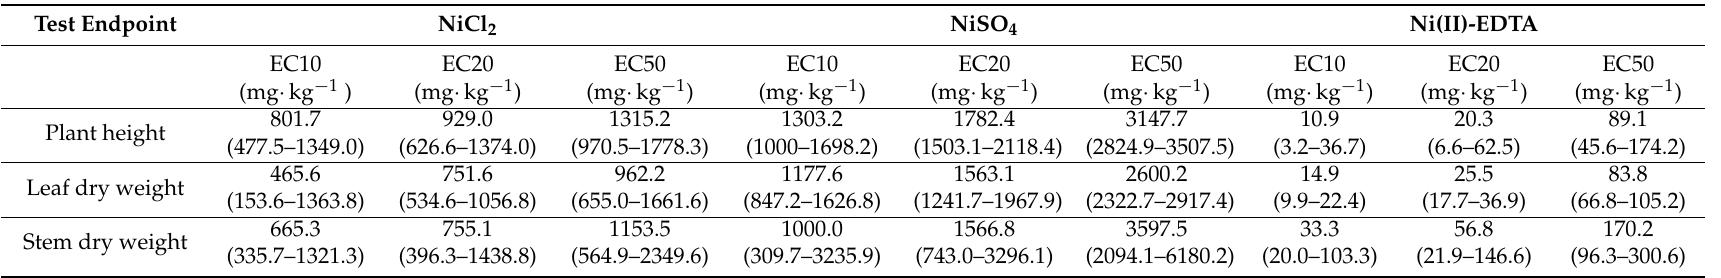
Table 1. Effective concentrations of Ni added to the soil as NiCl 2 ¨ 6H 2 O, NiSO 4 ¨ 6H 2 O, and Ni(II)-EDTA in relation to plant height and the leaf and stem dry weight of maize seedlings.